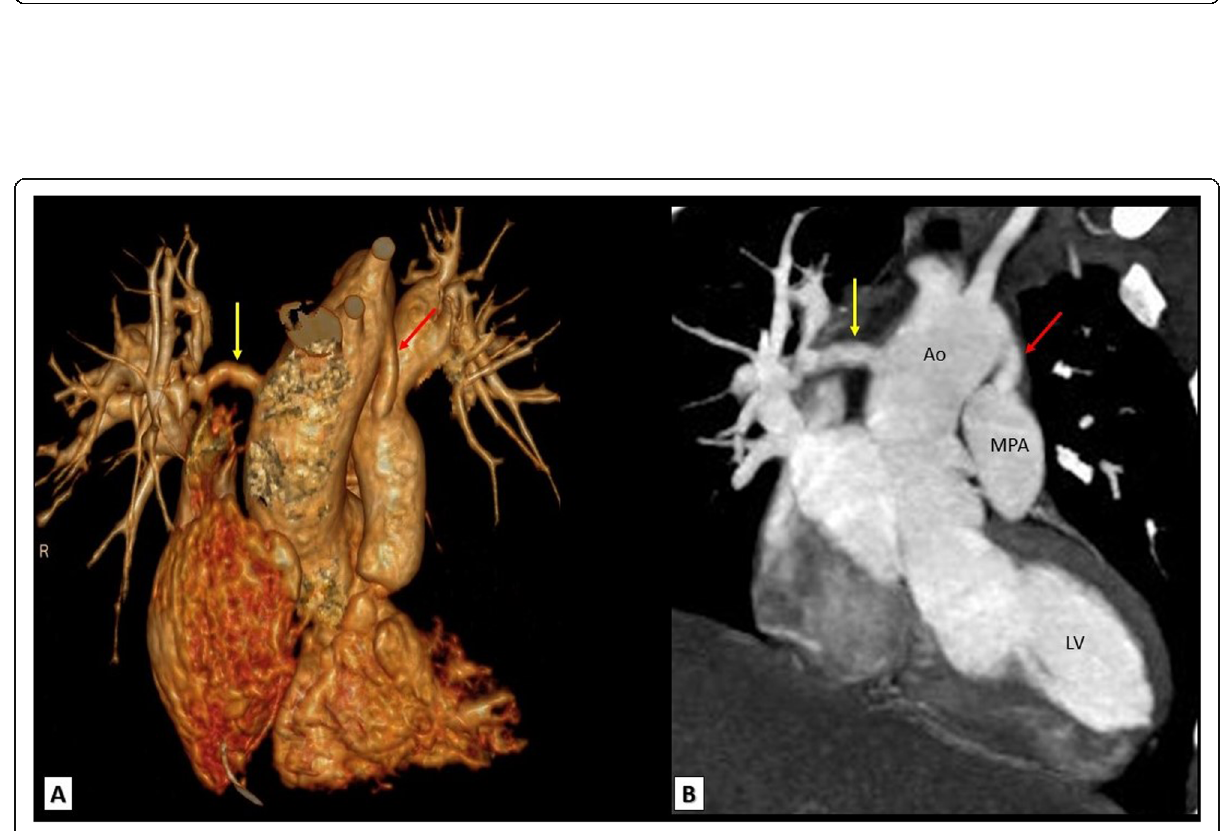
Fig. 8 a A 3D VRT. b Reconstructed coronal and c reconstructed sagittal MDCT images showing a double-outlet right ventricle where the pulmonary artery and more than 50% of the aorta originate from the right ventricle. Note the RVOT obstruction (red arrows) and a significant conal branch crossing the RVOT that should be avoided during surgical incision. Ao, Aorta; LV, left ventricle; RV, right ventricle; LA, left